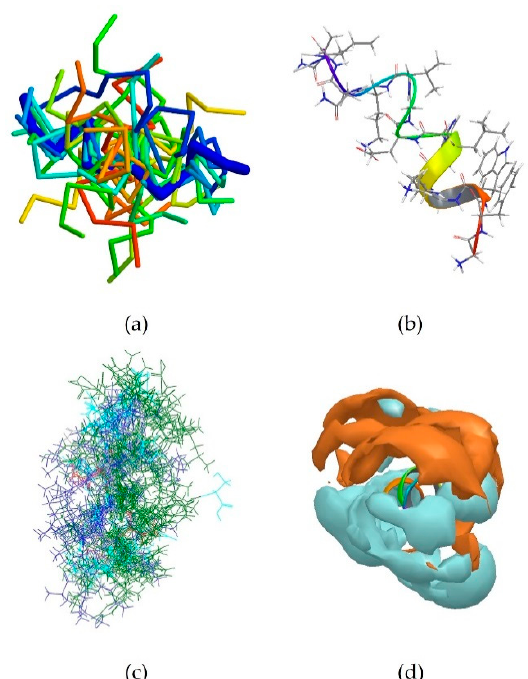
Figure 10. ( a ) The members of cluster 2 are shown superimposed to the centroid UyCT1 (thick blue trace); ( b ) Predicted conformation of UyCT1; ( c ) Side view of the peptides forming cluster 2 superimposed along the α -carbon. A colour scheme was applied according to residue properties: hydrophobic residues in green, positively-charged in blue, polar uncharged in cyan and negatively-charged in red. A clear separation between the two regions can be seen ( d ) The surface of the centroid UyCt1 is shown along the C -terminal side, with hydrophilic areas in cyan and hydrophobic regions in amber.